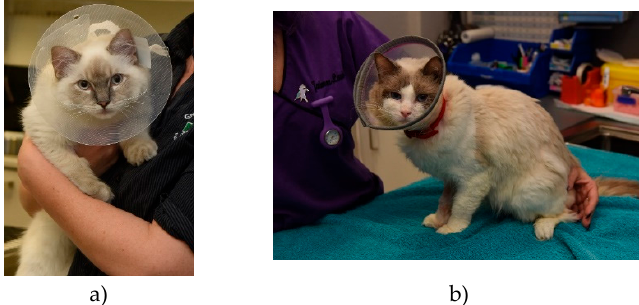
Figure 3. ( a,b ): Cats wearing commercially available, adjustable rigid plastic Elizabethan collars to protect surgical wounds.